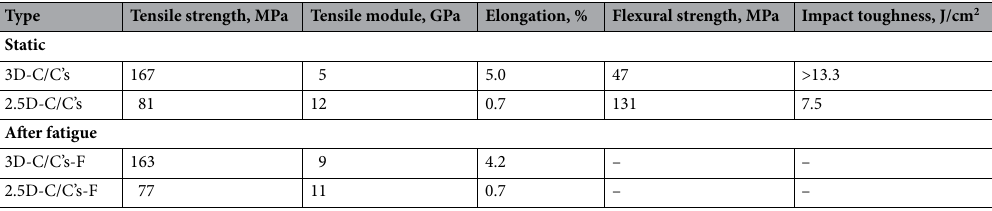
Table 2. Mechanical properties of C/C composites.